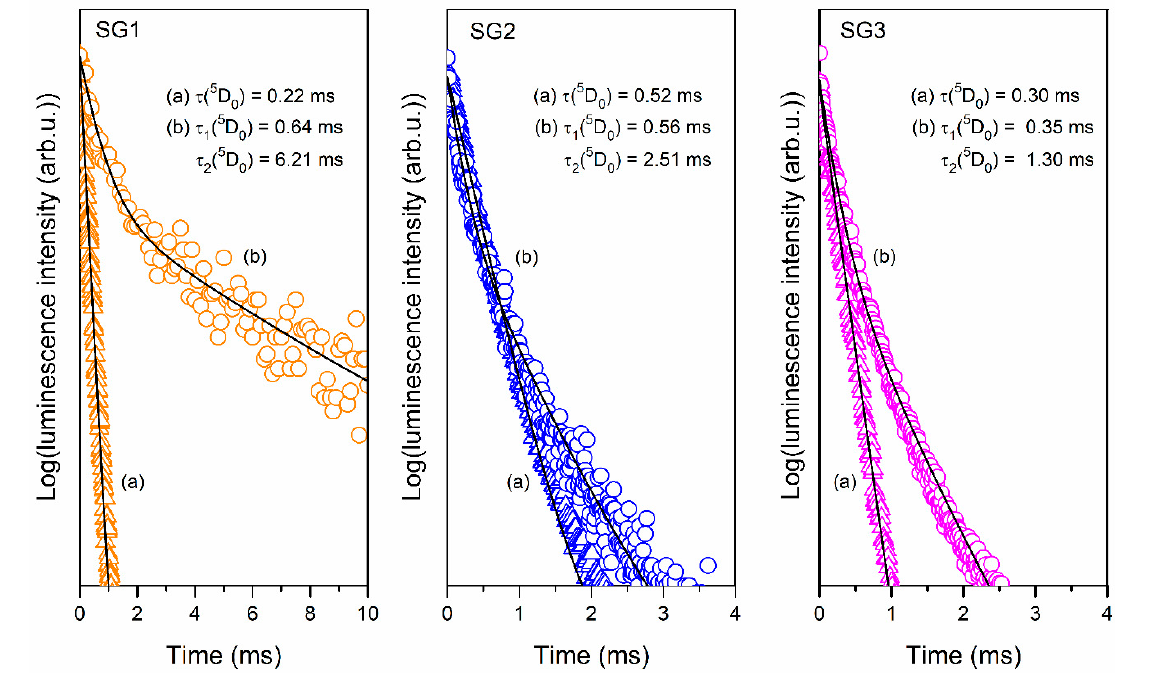
Figure 9. Luminescence decay curves of the 5 D 0 state of Eu 3+ recorded for xerogels ( a ) and glass–ceramics ( b ) ( λ exc = 393 nm, λ em = 612 nm).